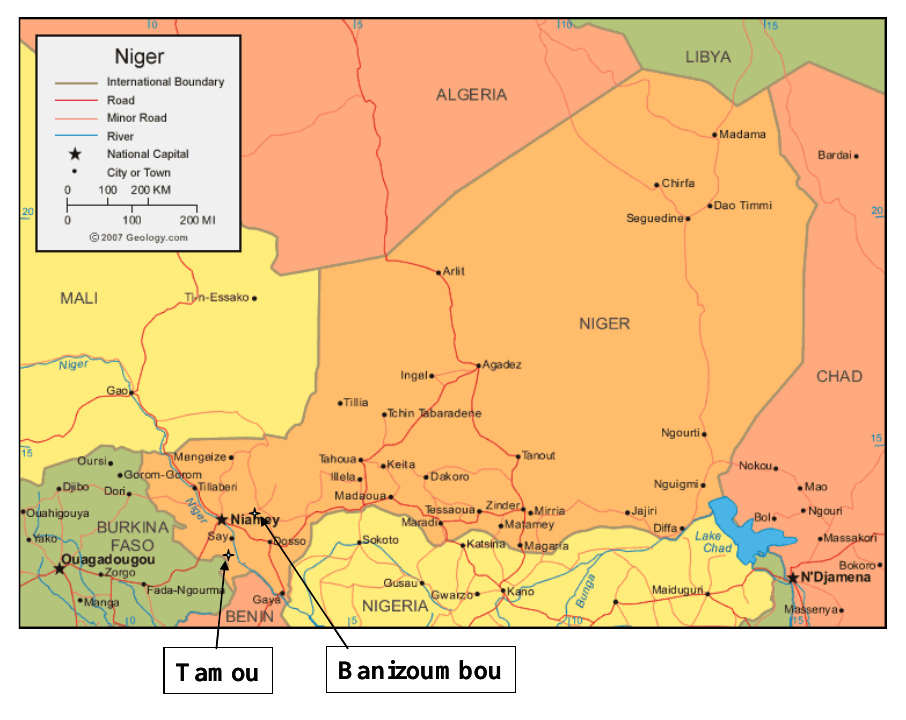
Figure 1. Location of Banizoumbou and Tamou study sites in